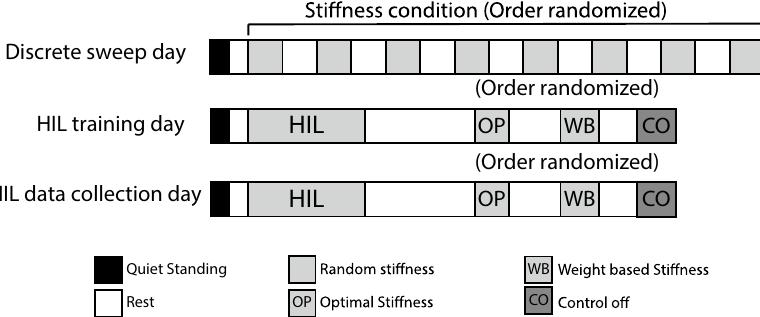
Figure 5. Experimental protocol. The first day was a discrete sweep day when randomly chosen stiffness parameters were tested. The second day was an HIL training day that allows participants to familiarize themselves with the HIL procedure. The final day was the data collection day of the HIL